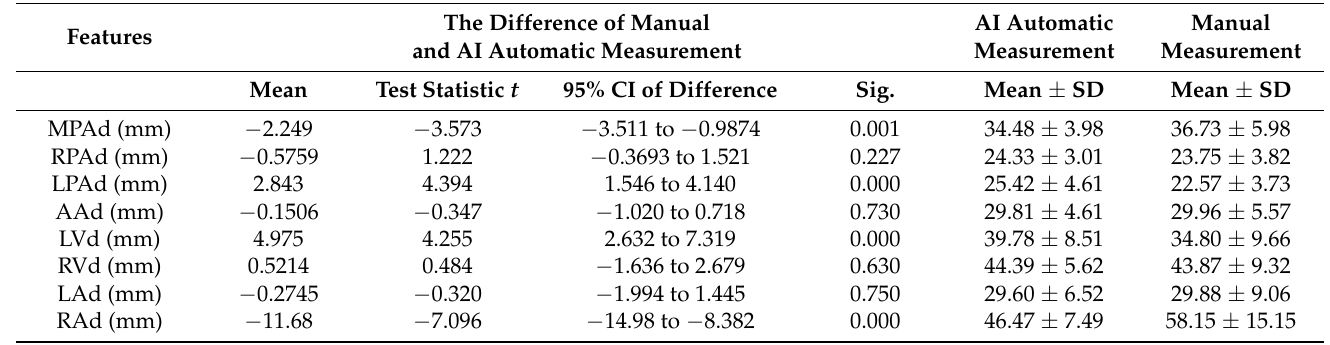
Table 3. Comparison of manual measurement and AI automatic measurement (paired samples t -test).